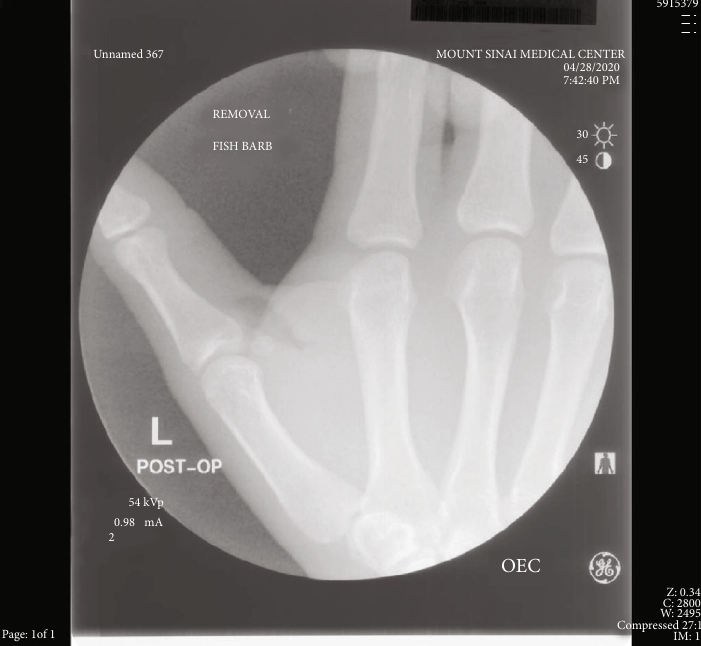
Figure 4: Subsequent fl uoroscopic spot view of the left hand demonstrated no residual foreign body. There is some post procedural subcutaneous gas in the area from recent surgical